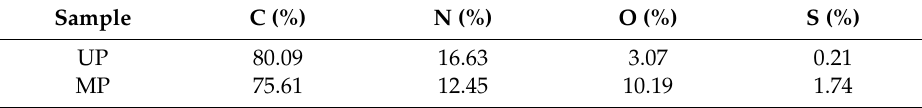
Table 2. Element amount of unmodified pigments (UP) and modified pigments (MP).